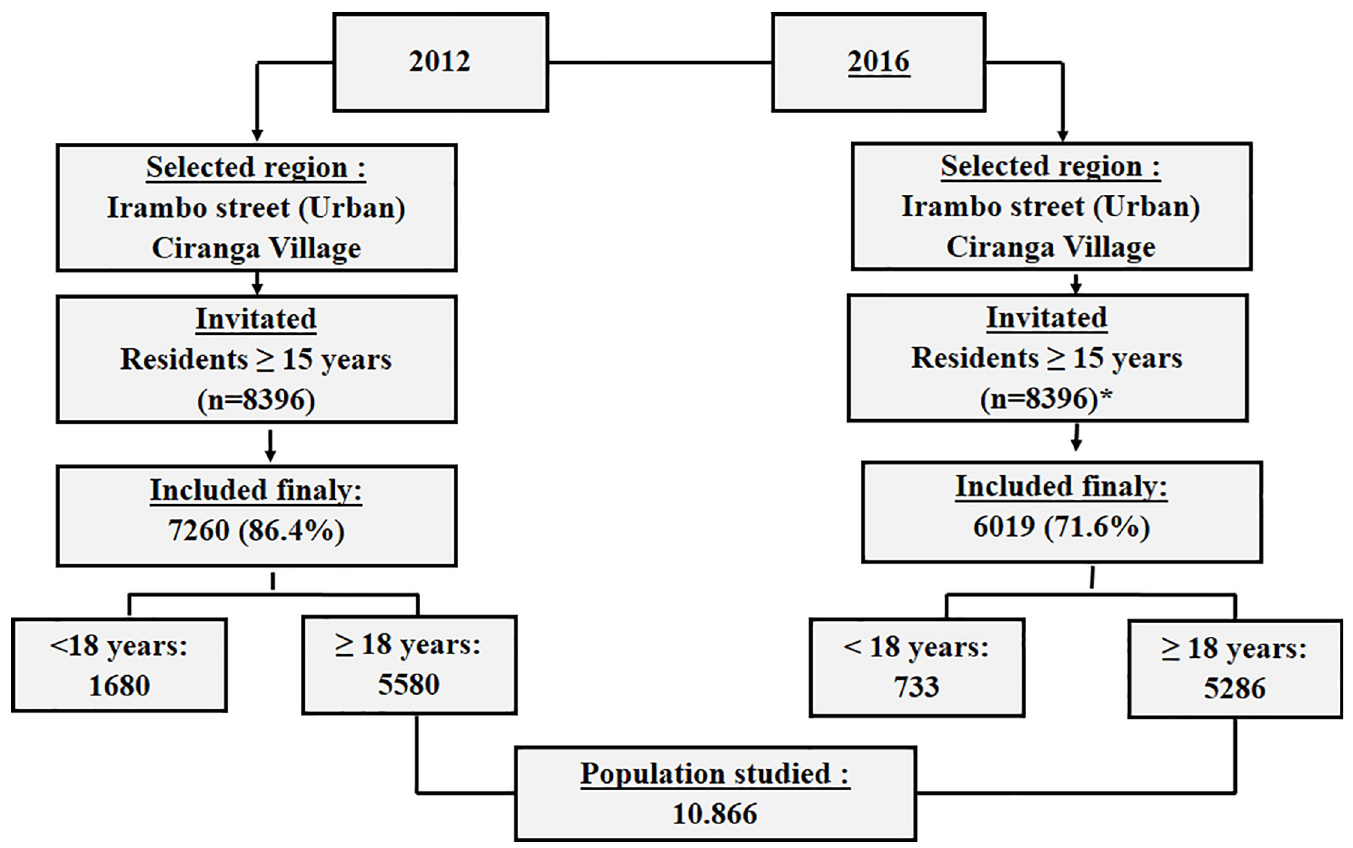
Fig 1. Identification process for eligible participants. � There was no census between 2012 and